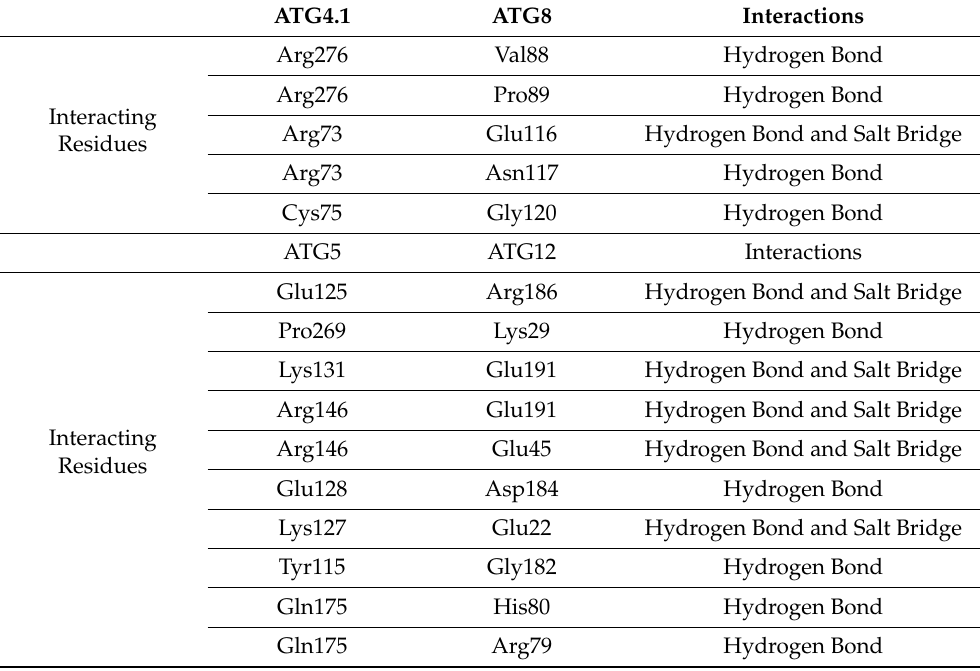
Table 2. ATG4.1-ATG8 and ATG5-ATG12 complexes interacting residues, as well as the type of interaction between interacting amino acids.